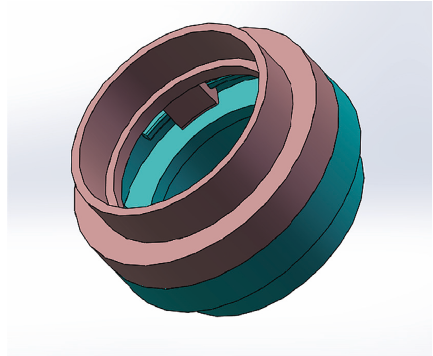
Figure 2: Three-dimensional view of the